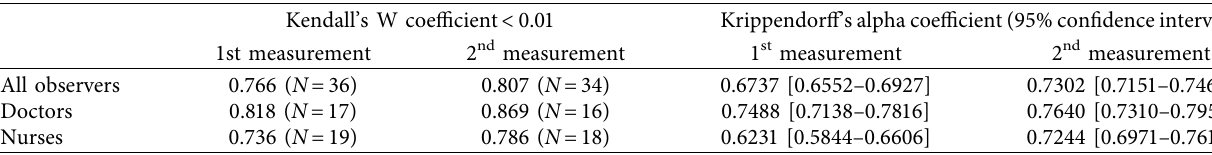
Table 5: NIPS total score: interrater reliability.